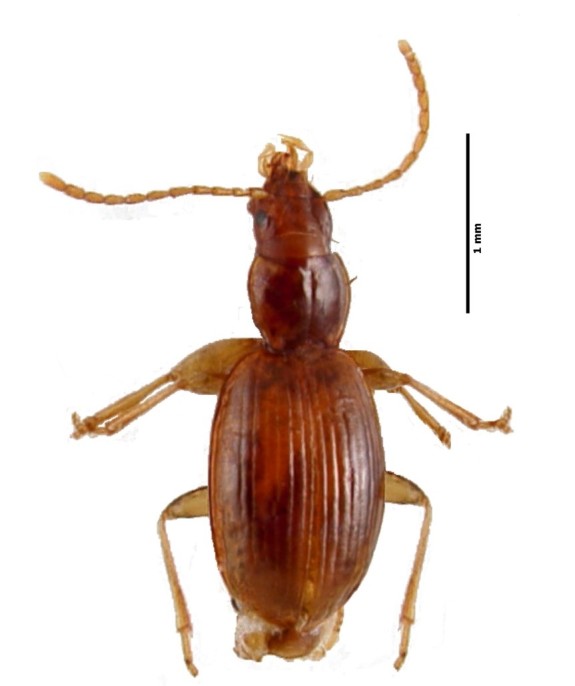
Trechus
pereirai (Borges, Serrano & Amorim, 2004) from Pico island (Azores, Portugal) (Credit: Enésima Mendonça).